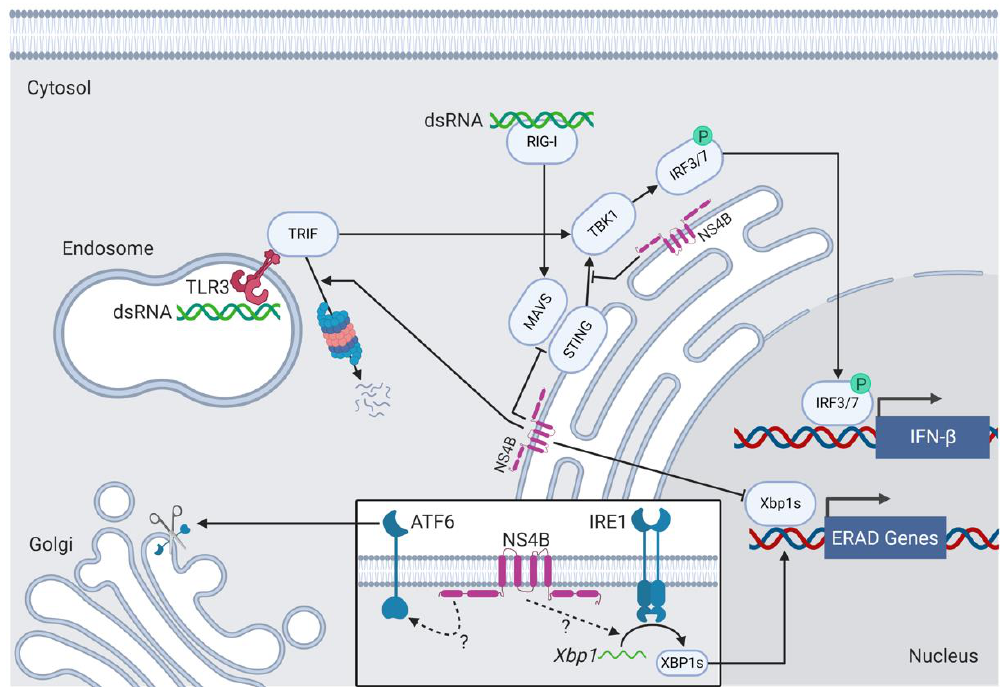
Figure 6. NS4B inhibits innate immune signal transduction and interacts with unfolded protein response sensor proteins. Cytoplasmic RIG-I and endosomal TLR3 sense HCV dsRNA and signal through MAVS and TRIF, respectively, leading to the TBK1-dependent phosphorylation and the activation of IRFs that drive IFN-β expression in the nucleus. The viral bZIP and transmembrane protein NS4B prevent the association of MAVS with STING and lead to the enhanced proteasomal degradation of TRIF to inhibit IFN-β production. NS4B also induces ATF6 cleavage and Xbp1 splicing by unknown mechanisms and therefore induces the UPR. NS4B inhibits the XBP1s-dependent expression of ER-associated degradation genes.